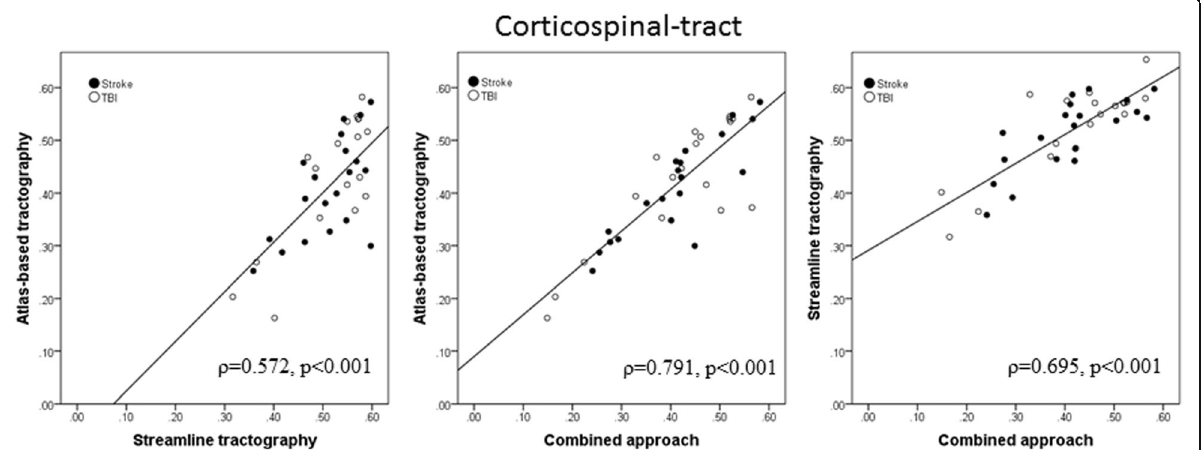
Fig. 3 Scatterplot depicting the mean fractional anisotropy values measured with atlas-based, streamline tractography, and combined approach. Spearman rank correlation and injury (stroke and traumatic brain injury [TBI] included)